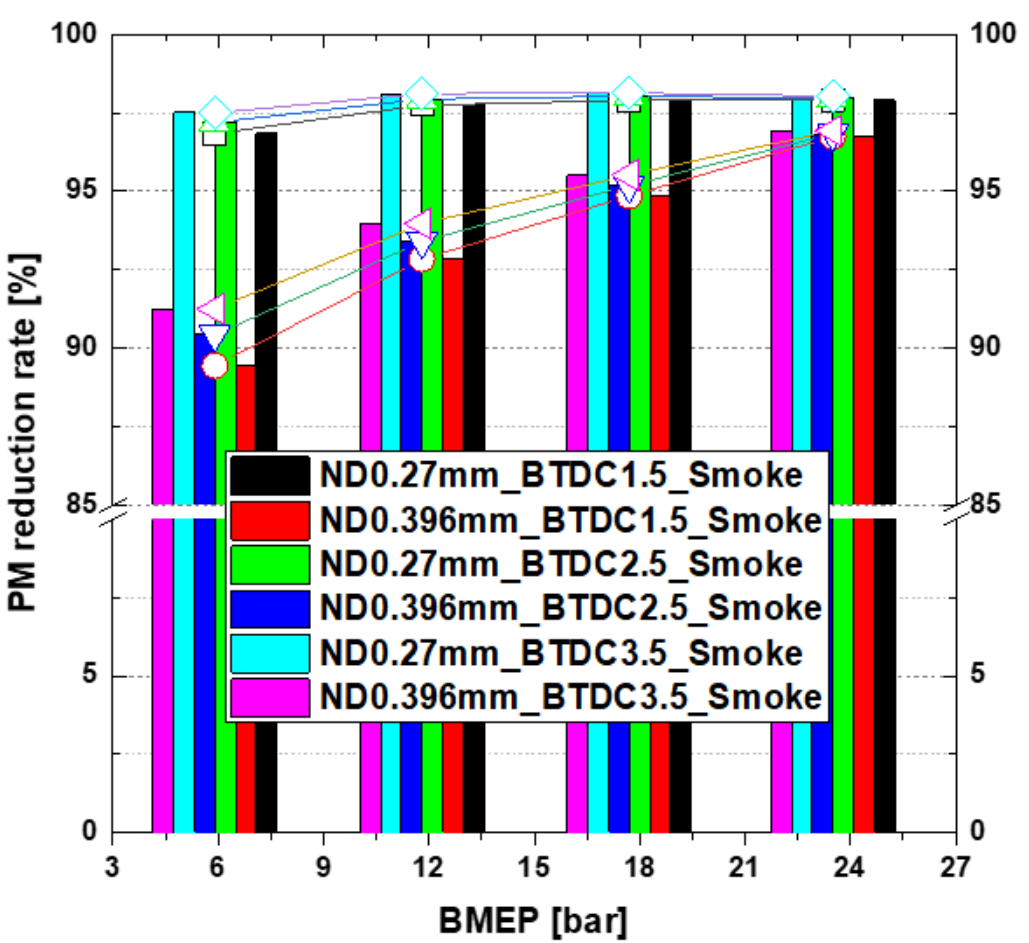
Figure 11. Particulate matter reduction rate according to injection timing and the ratio of the nozzle hole diameter with DME fuels. hole diameter with DME